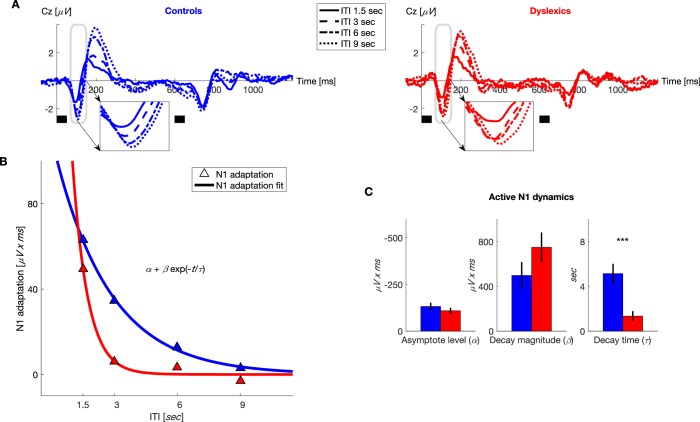
Dyslexics’ decay of N1 adaptation was faster than that of controls.(A) Grand average ERPs, plotted separately for blocks with different ITIs, for controls (n = 23; blue, left) and dyslexics (n = 25; red, right). Timing of the two tones in each trial is denoted by the short black bars under the plots. Insets: N1 range enlarged. Dyslexics’ N1 almost reached its full magnitude at an ITI of 3 s, whereas controls’ N1 reached its near-full magnitude only at an ITI of 6 s. (B) The decrease in N1 adaptation (circles) and the fitted exponential decay model (lines) as a function of ITI (curves were fitted to groups’ means). (C) Groups’ mean and SEMs of individually fitted estimated parameters of the exponential decay model of N1 recovery from adaptation. Only τ significantly differed between the two groups (p<0.0001).